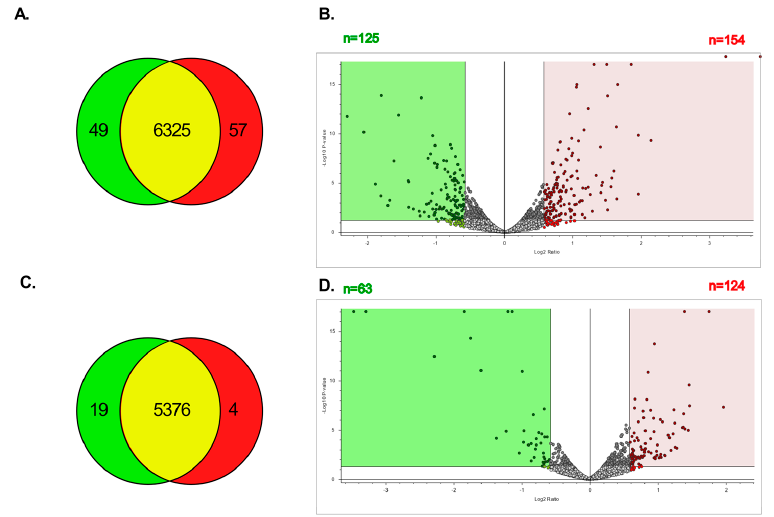
Figure 4. Total number of proteins identified in parental and CBPR cell lines. ( A ) Proteins identified in OVCAR-5 cell line pair: OVCAR-5 parental total = 6374, OVCAR-5 CBPR total = 6382, OVCAR-5 parental exclusive = 49, OVCAR-5 CBPR exclusive = 57, in both OVCAR-5 parental and CBPR = 6325. ( B ) Volcano plot showing proteins with 1.5-fold (=0.58 log2) differential abundance in OVCAR-5 parental compared to CBPR. A total of 154 proteins were upregulated and 125 proteins were downregulated in parental OVCAR-5 cells. ( C ) Proteins identified in CaOV3 cell line pair: CaOV3 parental total = 5395, CaOV3 CBPR total = 5380, CaOV3 parental exclusive = 19, CaOV3 CBPR exclusive = 4, in both CaOV3 parental and CBPR: 5399. ( D ) Volcano plot showing proteins 1.5-fold (=0.58 log2) differentially abundant in CaOV3 parental compared to CBPR. A total of 124 proteins were seen to be upregulated and 63 proteins were downregulated in parental CaOV3 cells. 3.7. Separation of Ovarian Cancer Cell Lines Based on Proteomic Profiles The Proteome discoverer software was used to generate PCA plots and heat maps to investigate the separation of parental and CBPR cell lines based on their molecular fea- tures. The PCA plots demonstrated a robust separation between the parental and CBPR cell lines based on their proteomic profiles (Figure 5A,C). This was further supported by hierarchical clustering and was visualised in the heat maps (Figure 5B,D).